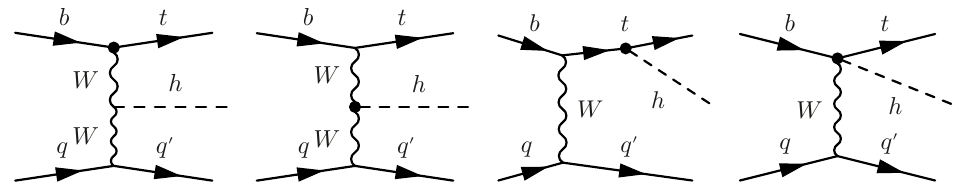
Figure 2 . Representative LO Feynman diagrams for tHj production in the SMEFT. The operator insertions (black dots) correspond to operators involving either electroweak gauge boson or third generation fermion interactions. These can modify existing SM interactions such as the top Yukawa or Higgs- W - W interaction, induce new Lorentz structures, e.g., with the weak dipole operators or mediate new contact interactions between fermion currents and two EW bosons. Equivalent diagrams for the tZj process can be obtained by replacing the Higgs with a Z boson and keeping in mind that the Z boson can also couple to the light-quark